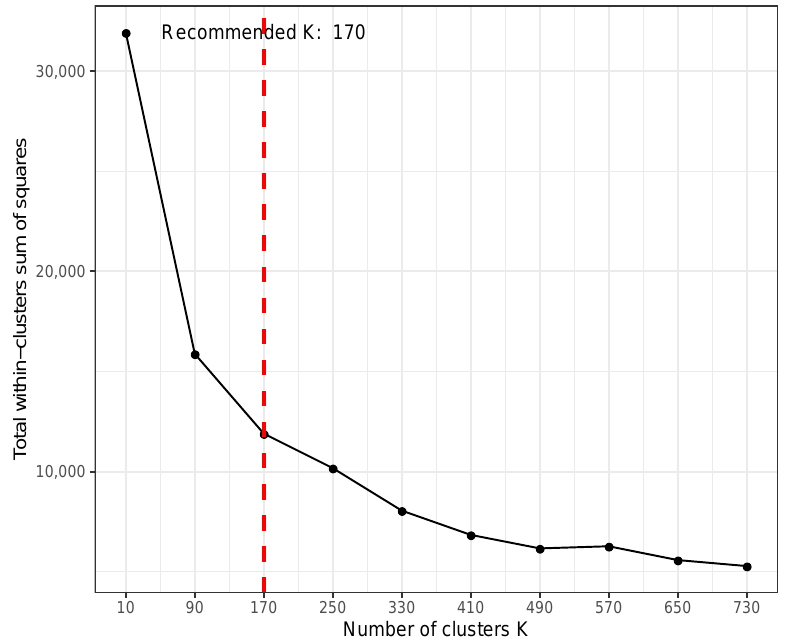
Figure 4. An example result of K -test using time course gene expression data with five conditions and three